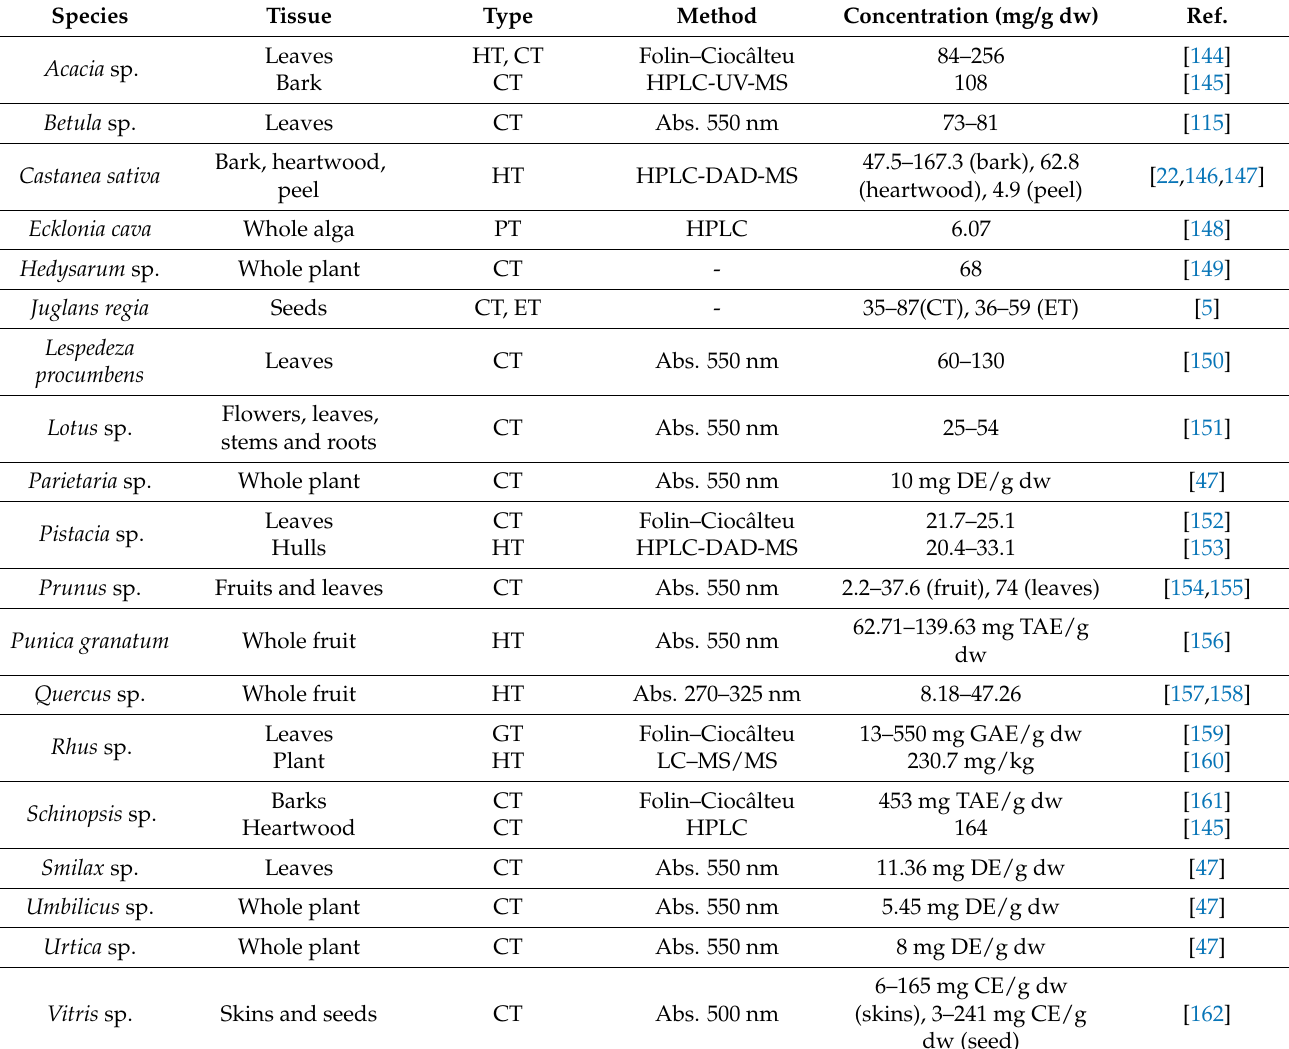
Table 3. Important species as sources of tannins. Quantitative data of hydrolyzable and condensed tannins (expressed in mg/g of dry weight (dw), except when other units were indicated) determined using different detection methods in specific tissues of the indicated